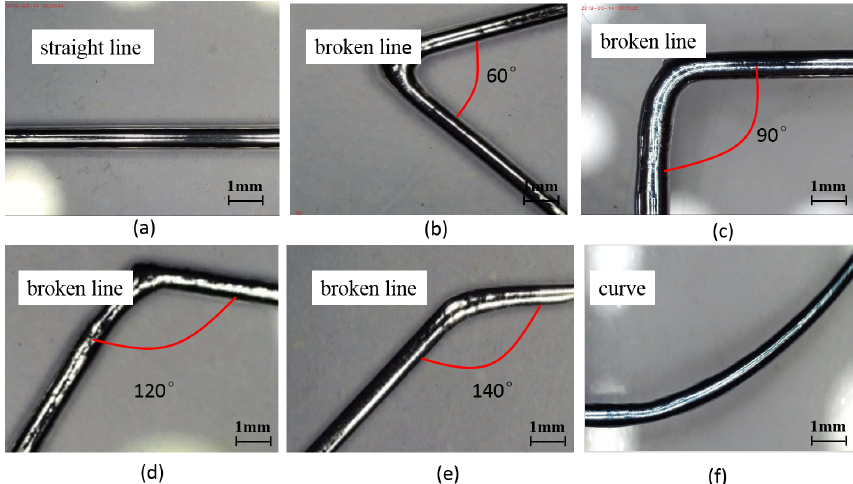
Figure 10. Different printed line elements: (a) linear segment; (b–e) corners with different angles; (f) curve.